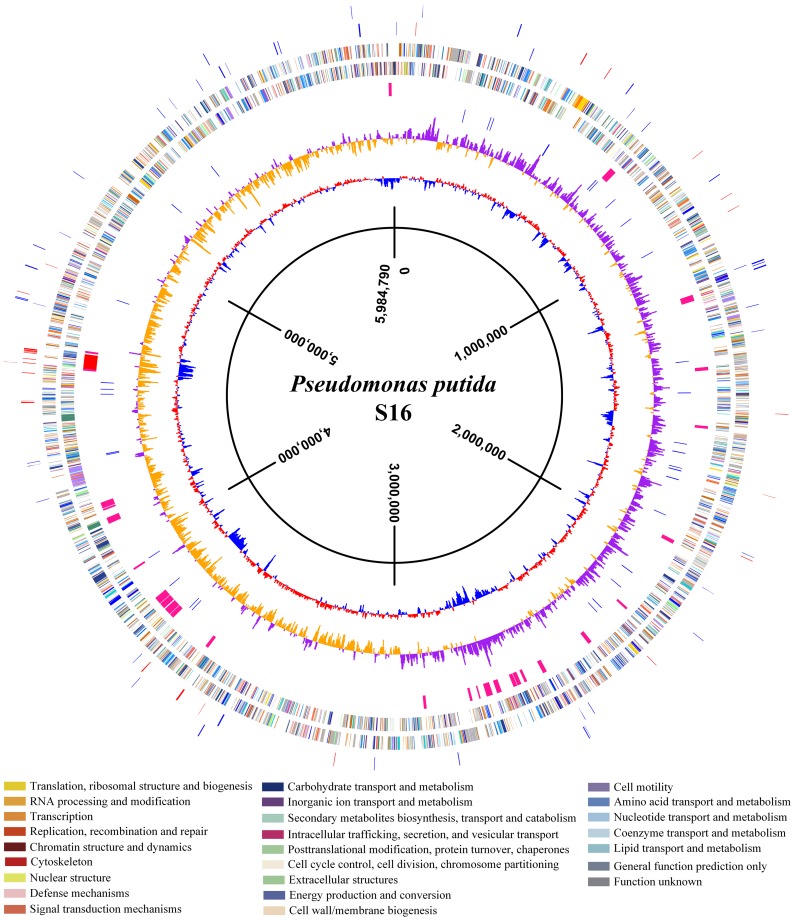
A map of the circular chromosome of P. putida S16.The map illustrated the location of known genes, predicted coding regions, genome islands, and differentially expressed proteins. From the outside inwards, circle 1 and circle 2 indicate the protein in the clockwise and anti-clockwise direction that was differentially expressed (> = 3-fold changes and p-values<0.05) in nicotine medium and glycerol medium. The red lines indicate proteins up-expression in nicotine medium, and blue lines indicate proteins up-expression in glycerol medium. Circle 3 and circle 4 indicate the predicted CDSs in the clockwise and anti-clockwise directions, analyzed using the COG database (colors were assigned according to the color code of the COG functional classes); Circle 5 indicates the genome islands predicted in the S16 genome. The red line represents the biggest genome island in S16, in which the nicotine degradation cluster is located in the circle. Circle 6 indicates tRNAs; circle 7 and circle 8 indicate the value of GC skew (G−C/G+C) and percentage of GC content, respectively, with a 4000-bp window size and 2000-bp overlap.